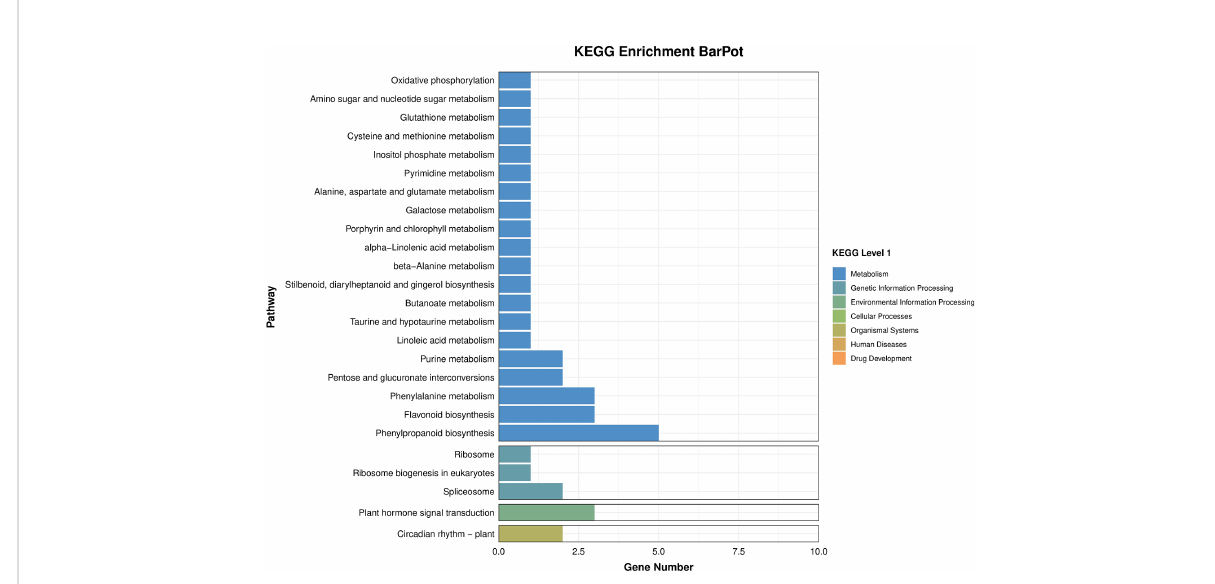
FIGURE 3 Classi fi cation of differentially expressed genes. Total gene counts of KEEG terms are associated with all